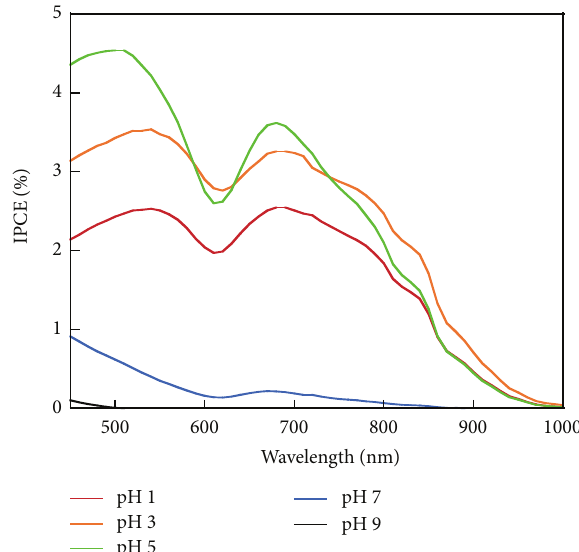
Figure 2: IPCE spectra of Au 25 cluster solutions at different pHs.